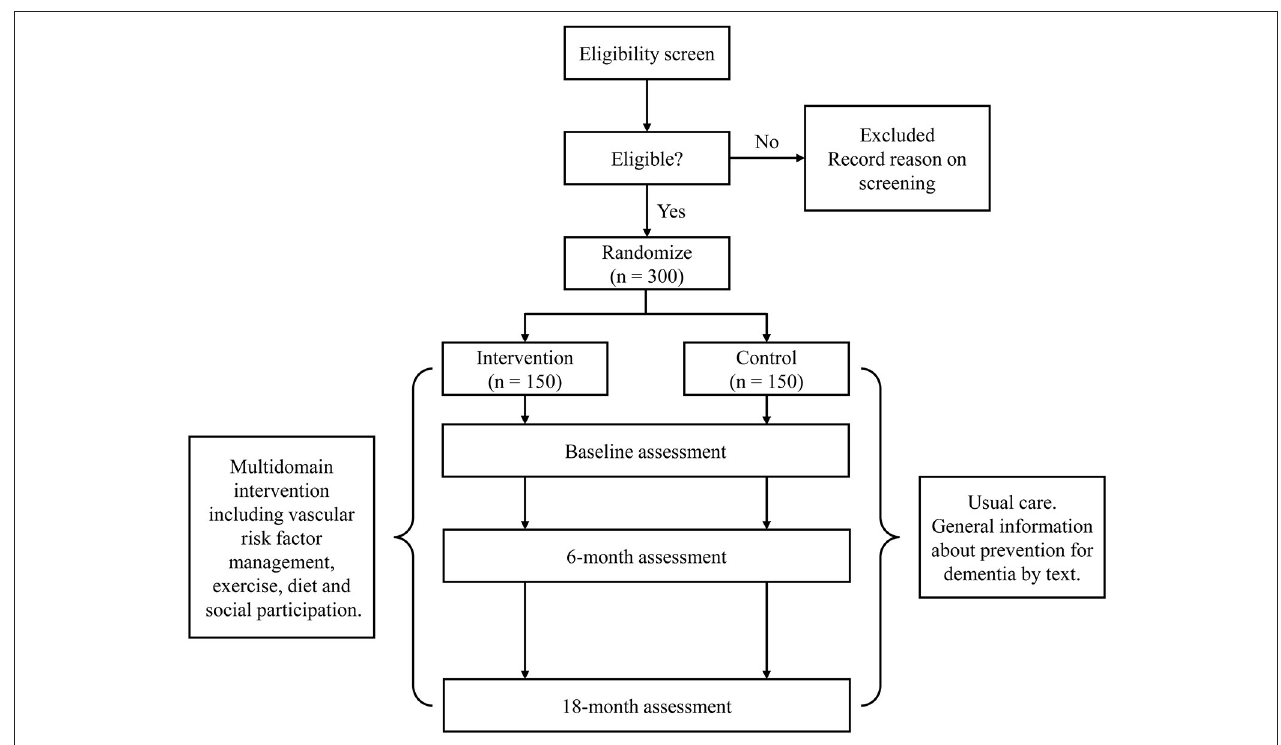
FIGURE 1 | Study flow of the Japan-multi-domain intervention trial for prevention of dementia in older adults with diabetes (J-MIND-Diabetes).